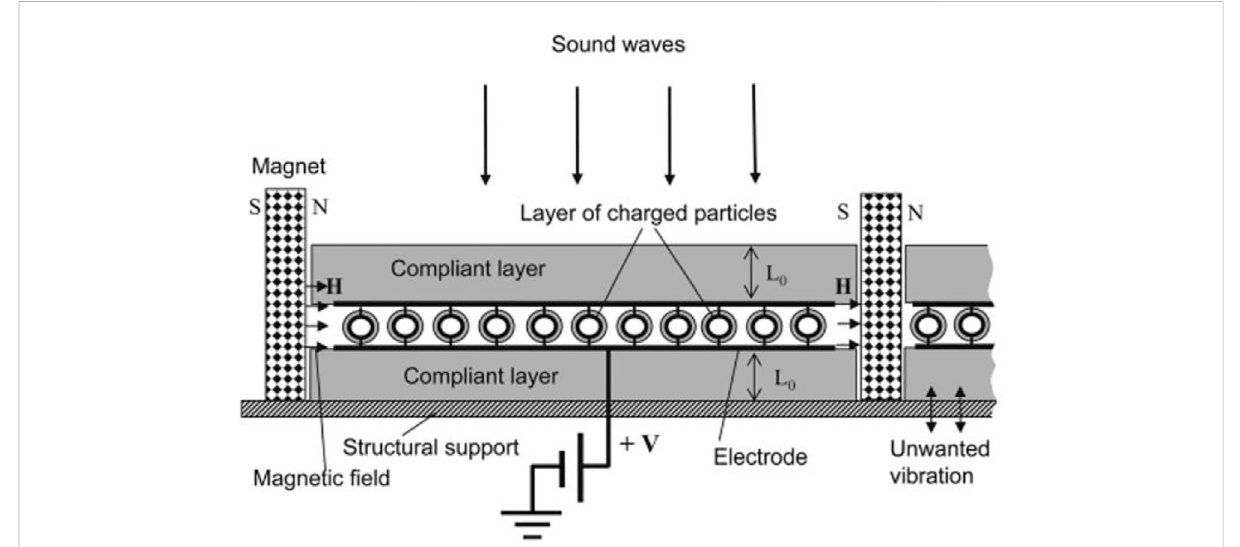
FIGURE 9 Schematic diagram of the implementation example. Reprinted from [35] with permission.